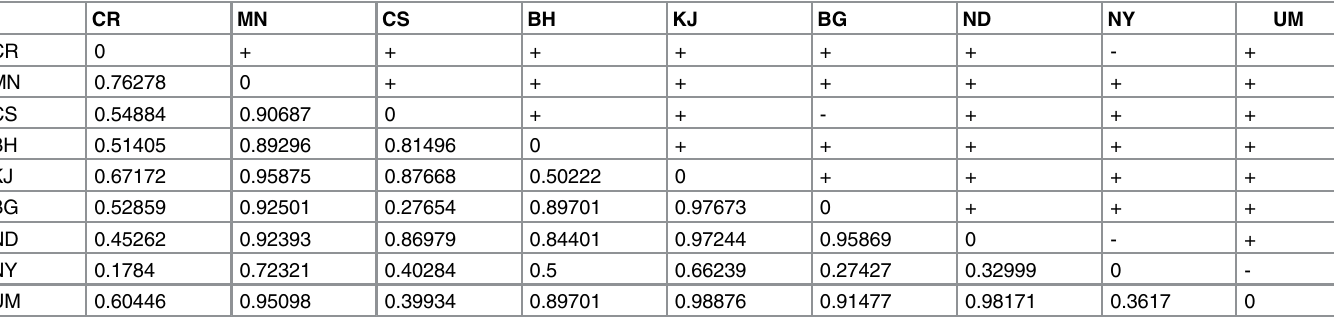
Table 3. Pairwise F ST values between fragments (below diagonal) and their significance (above diagonal) after 10,000 permutations.